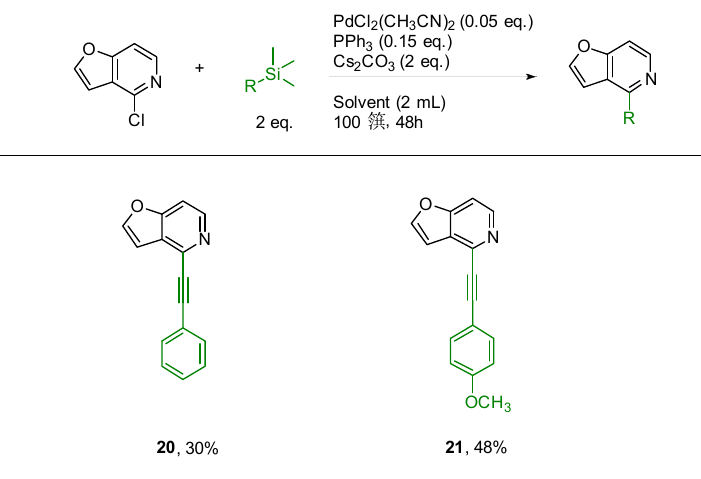
Figure 7. Scope and limitations of the Hiyama coupling from 4-chlorofuro[3,2- c ]pyridine.